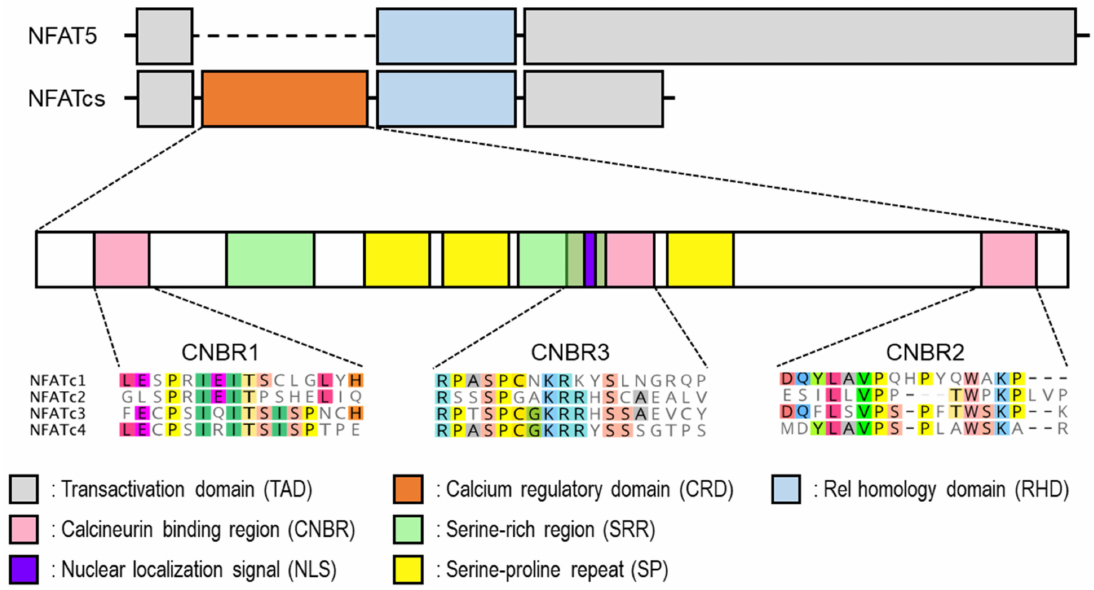
Figure 1. Differences in the structure, functional domains, and amino acid sequences of nuclear factor of activated T cell (NFAT) family